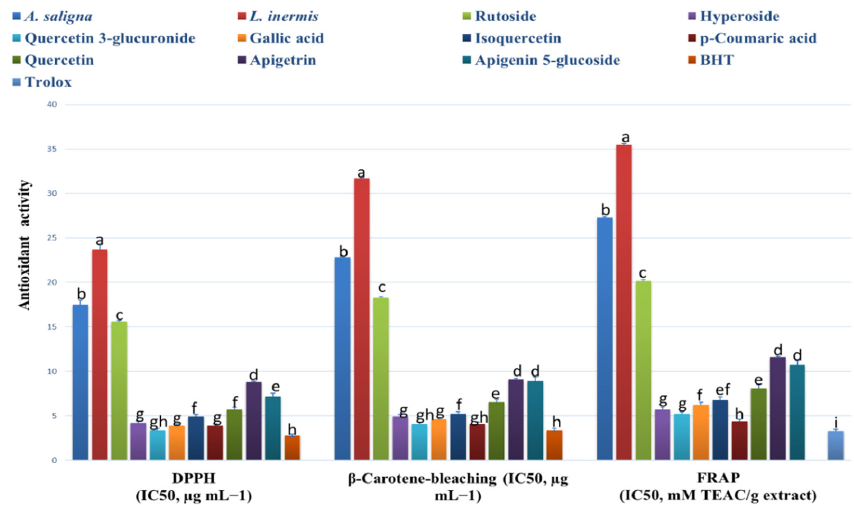
Figure 2. A. saligna and L. inermis antioxidant effects using 2,2-diphenyl-1-picrylhydrazyl (DPPH), β -Carotene bleaching and ferric reducing antioxidant power (FRAP) assays (expressed as IC 50 in μ g/mL). Identified polyphenol (rutoside, hyperoside, quercetin 3-glucuronide, gallic acid, isoquercetin, p- coumaric acid, quercitrin, apigetrin and apigenin 5-glucoside) antioxidant effects were also added. Values are expressed as mean ± standard deviation. TEAC: Trolox equivalent antioxidant capacity. Different letters among group of columns indicate significant differences ( p ≤ 0.05).